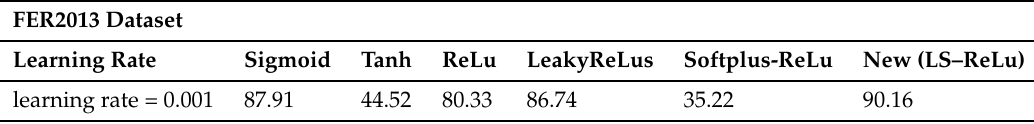
Table 5. This table summarises the average accuracy rates produced by different common activation functions and the new activation function in facial expression recognition on FER2013 database.